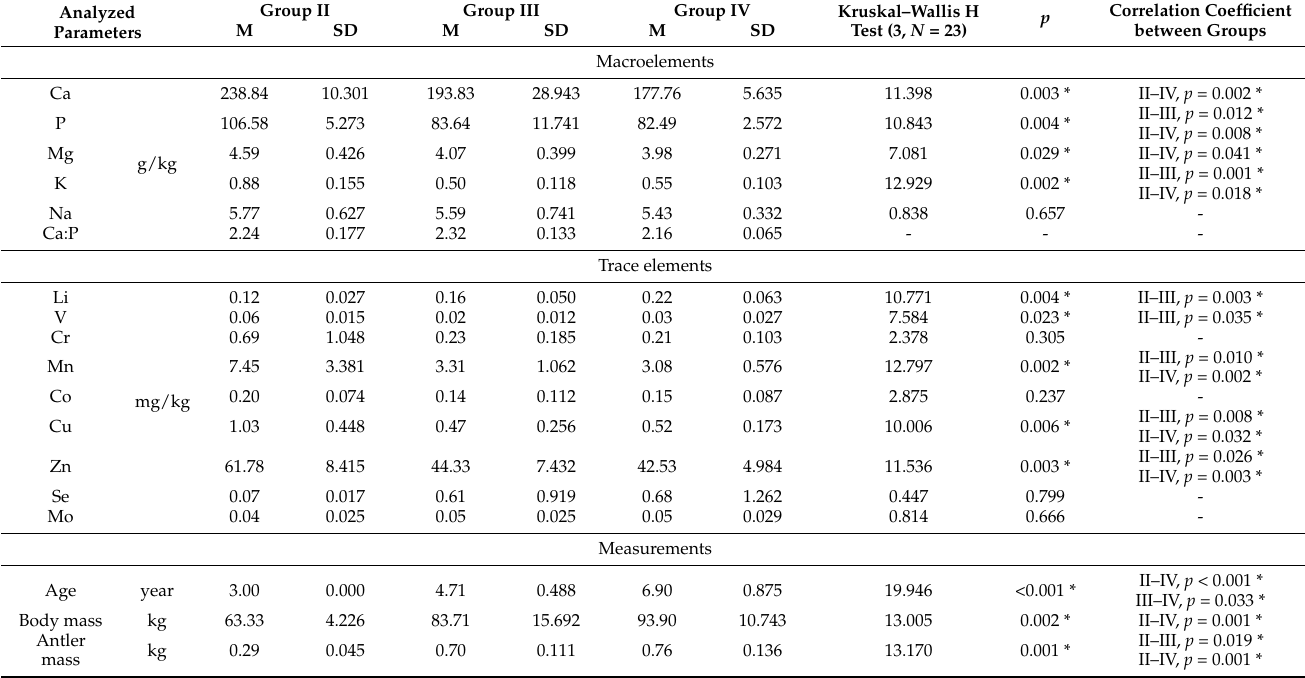
Table 3. Comparison of the mean measurements from three sites between the three groups of